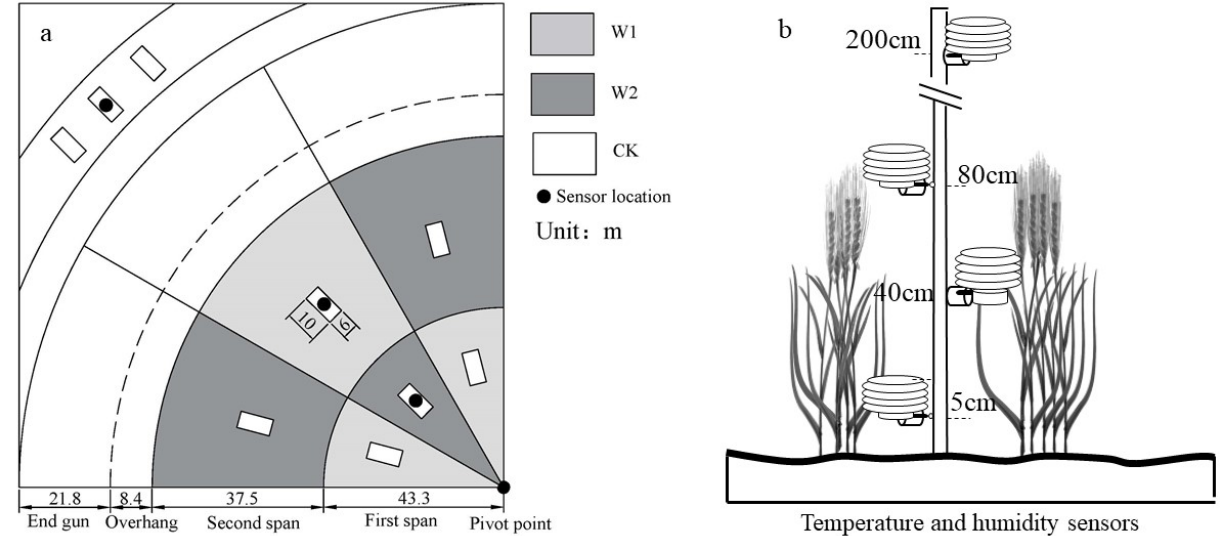
Figure 1. Schematic diagram of center pivot, layout of plots ( a ), and schematic diagram of temperature and humidity sensors ( b ). W1, W2 and CK represent 2.5 mm, 5 mm, and no irrigation treatments during dry-hot wind condition, respectively. Four sets of temperature and humidity sensors were installed at 5, 40, 80 and 200 cm from the ground surface.